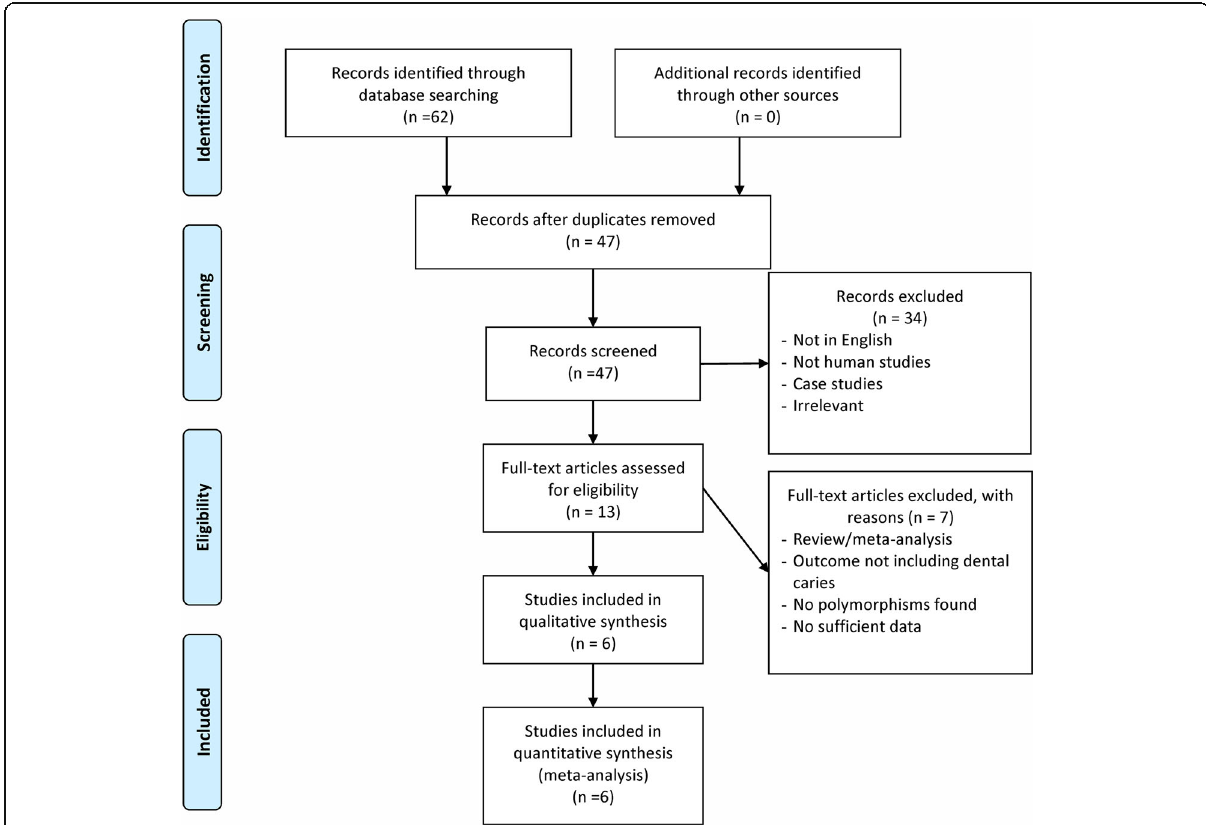
Fig. 1 Flow diagram of the selection process of the studies included in the meta-analyses. Note: Please see the Methods section